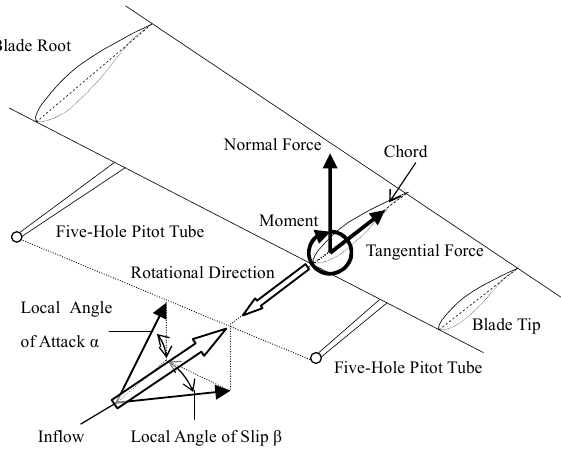
Fig.6 Definition of normal force, tangential force, moment, local angle of attack and local slip